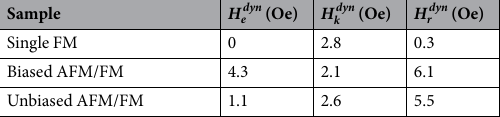
Table 1. Dynamic anisotropies of the films.